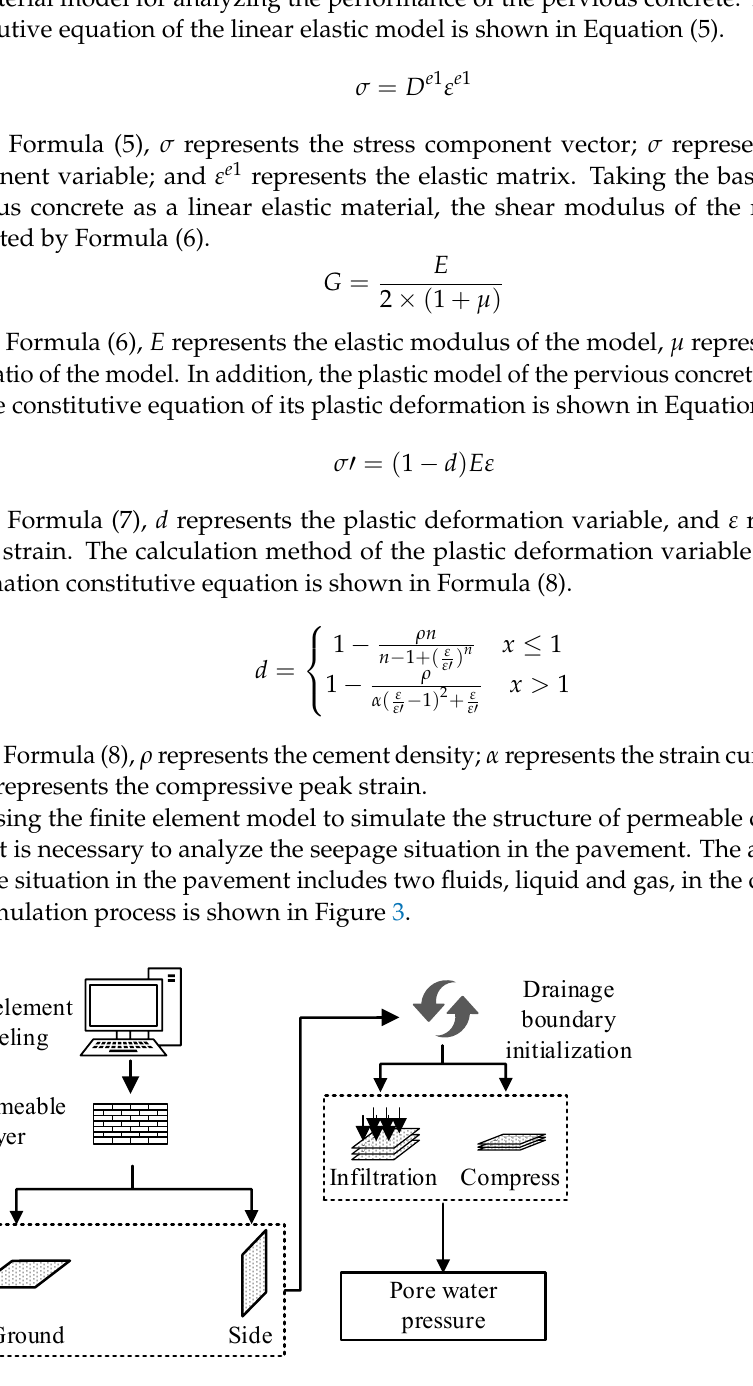
Figure 3. Finite element model simulation process.